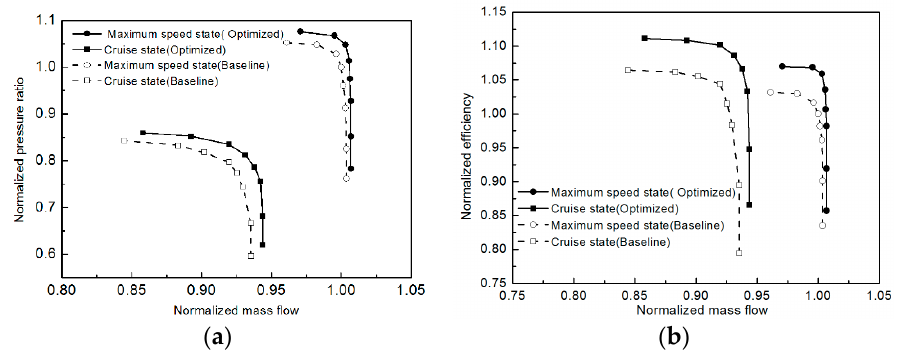
Figure 12. Baseline and optimum characteristics: ( a ) diagram of normalized pressure ratio with respect to normalized mass flow; ( b ) diagram of normalized efficiency with respect to normalized mass flow.